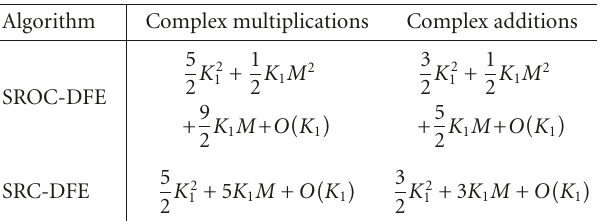
Table 1: Computational complexity of the proposed algorithms. Algorithm Complex